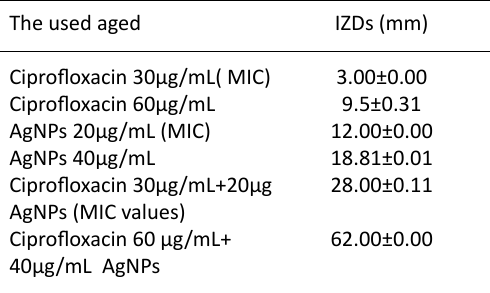
Table 3. Inhibition of S.aureus by combinations of both